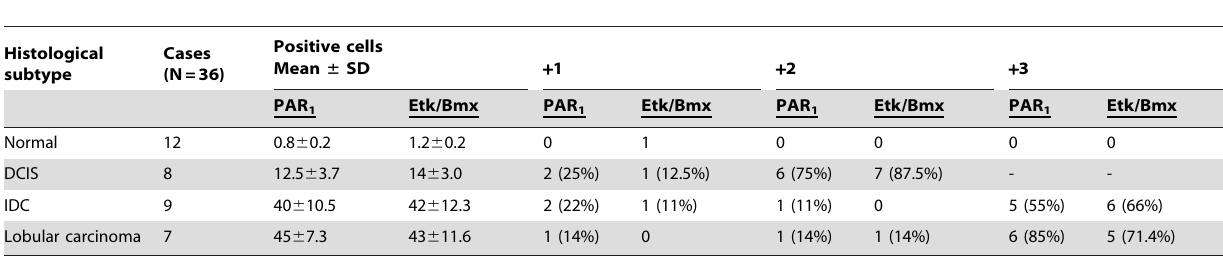
Table 1. Expression of PAR 1 and Etk/Bmx in breast cancer biopsy specimens (representing Fig. 5D).